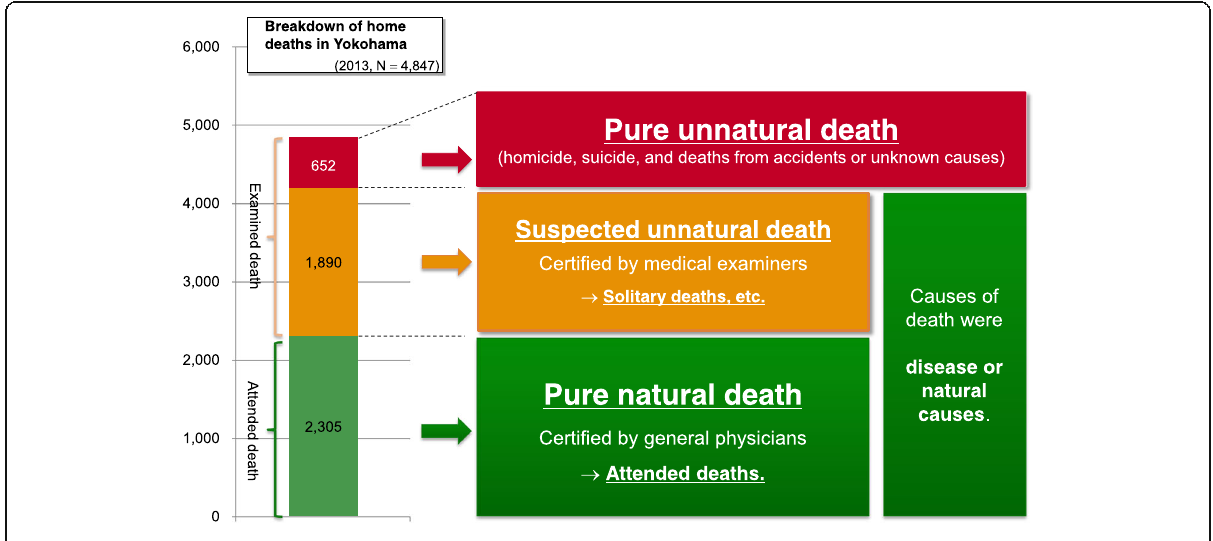
Fig. 1 Breakdown of home deaths in Yokohama City in 2013 by type of death